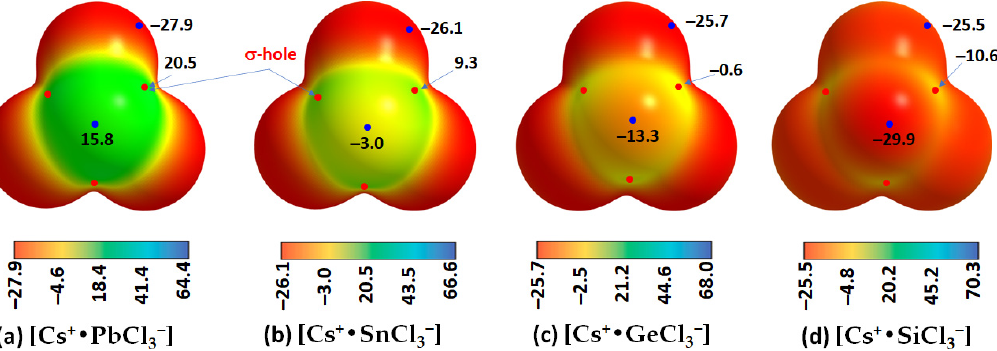
Figure 9. ( a – d ) The [ ω B97Xd/def2-TXVPPD] level potential on the electrostatic surface of Figure [Cs + •TtCl 3 − ] (Tt = Pb, Sn, Ge, Si) ion pairs, mapped on their corresponding 0.001 a.u. isoelectronic density envelopes. The Tt atom in [Cs + •TtCl 3 − ] faces the reader. Selected local most maxima and minima of potential ( V S,max and V S,min ) represented by tiny circles in red and blue, respectively, are depicted. Values are given in kcal mol − 1 .